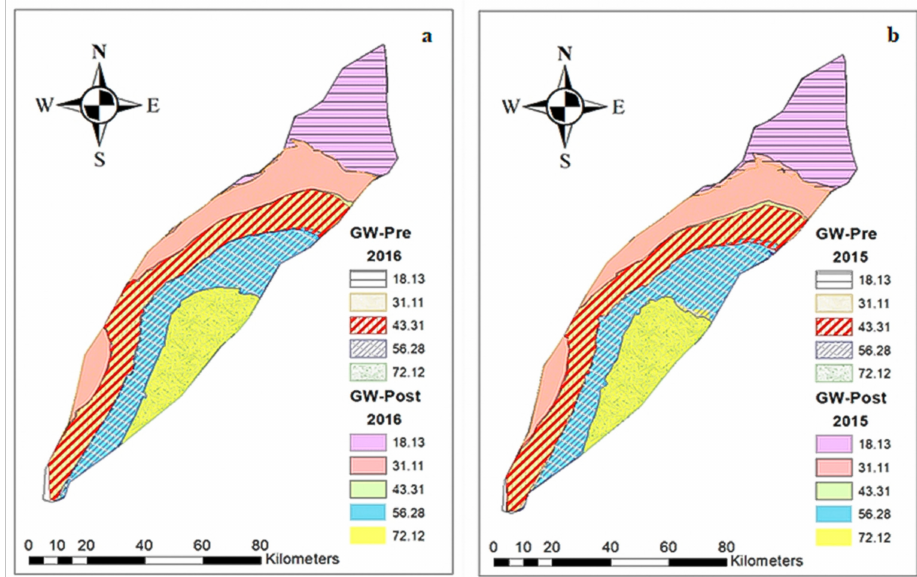
Figure 9. Overlay analysis of groundwater level. ( a ) GWL for 2015 ( b ) GWL for